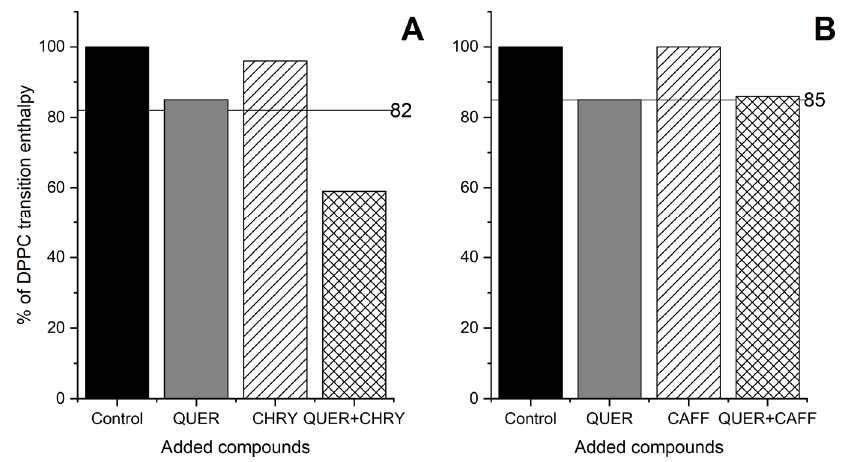
Figure 9. Synergy of compound combination calculated by Bliss independence. ( A ) Predicted reduction in transition enthalpy according to Bliss independence (horizontal line—82%) and observed reduction in transition enthalpy (QUER+CHRY column) when adding QUER/CHRY mixture to DPPC; ( B ) predicted reduction in transition enthalpy according to Bliss independence (horizontal line—85%) and observed reduction in transition enthalpy (QUER+CAFF column) when adding